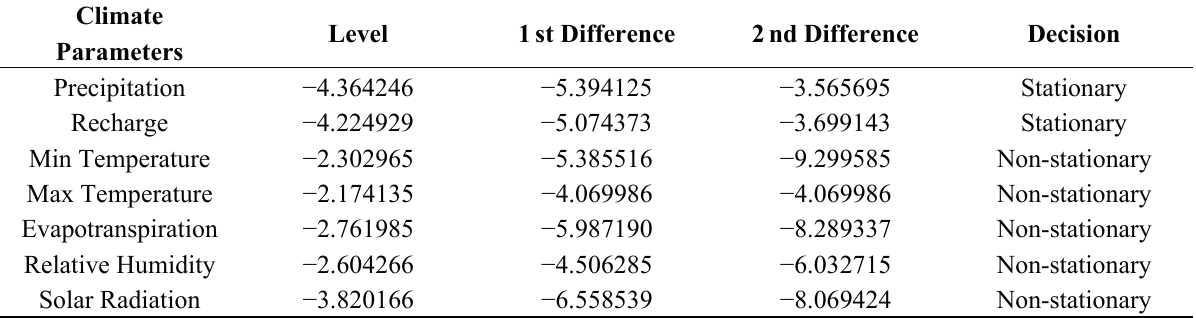
Table 2. Result of stationary test from the Augmented Dickey-Fuller